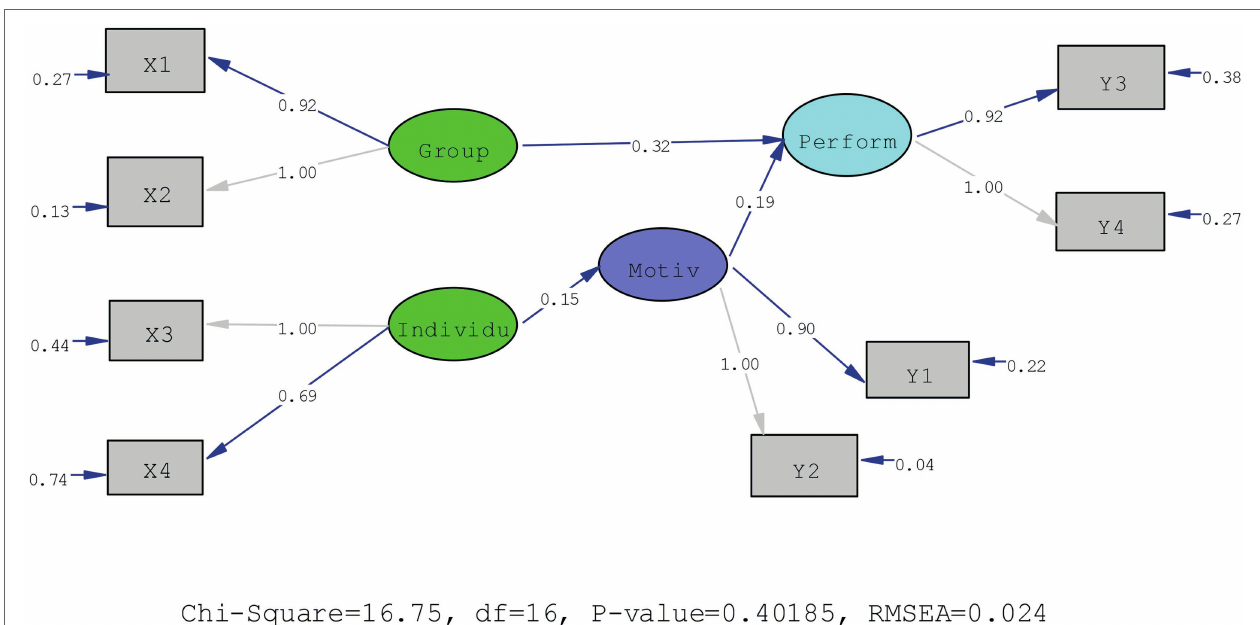
FIGURE 1 | Relationship between exogenous variables and endogenous variables. Group, group supervision technique; X1, group supervision by supervisor; X2, collegial group supervision; Individu, individual supervision technique; X3, individual supervision by supervisor; X4, self-directed supervision; Motiv, teachers’ work motivation; Y1, motivation in doing teaching and learning tasks; Y2, motivation in doing professional development tasks; Perform, teachers’ performance; Y3, the achievement of the work result based on the standard set; Y4, the achievement of the work result based on the